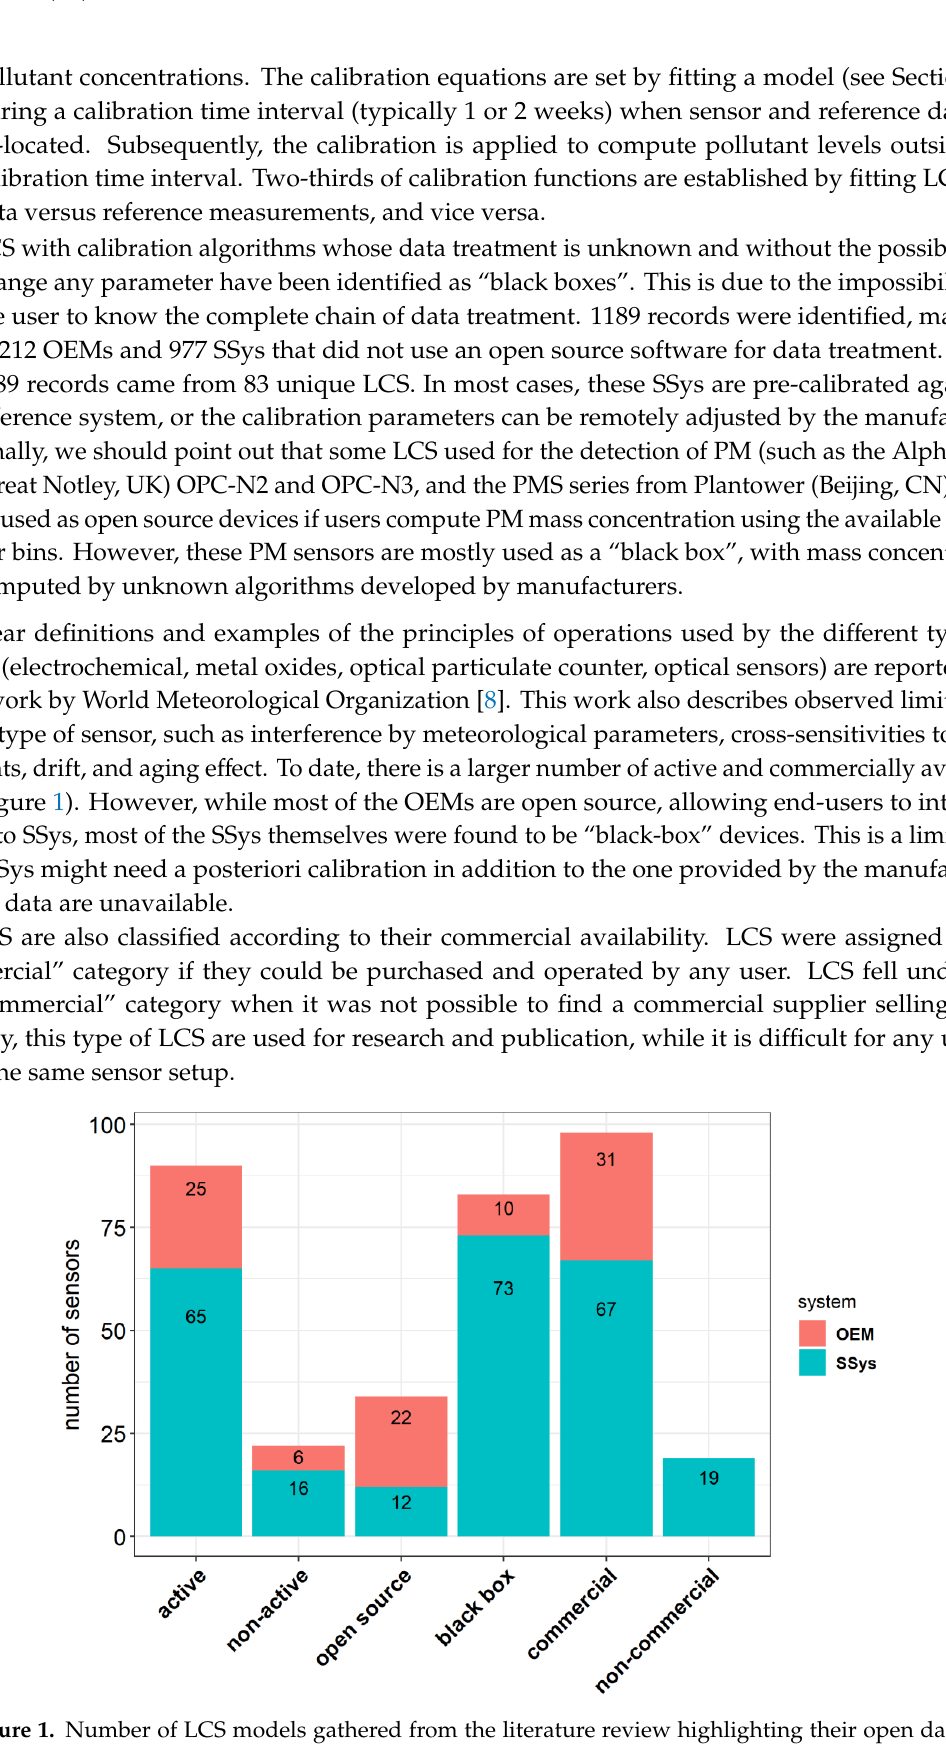
Figure 1. Number of LCS models gathered from the literature review highlighting their open data treatment (open source vs. black box) and commercial availability.